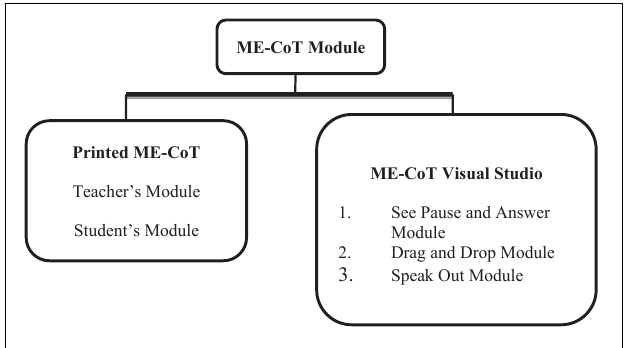
FIGURE 1 | Component of ME-CoT module.